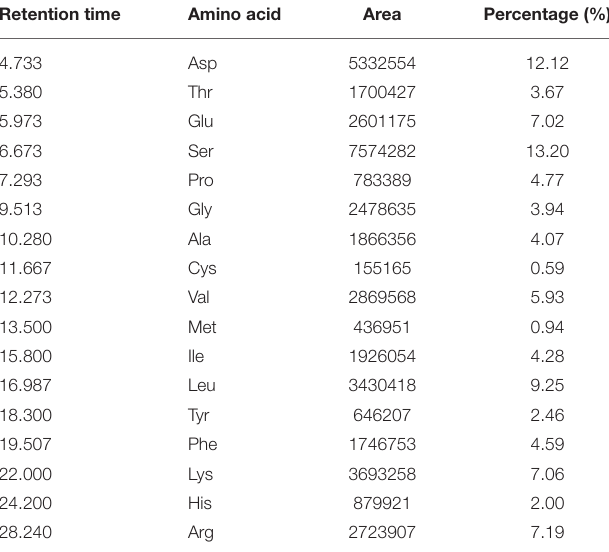
TABLE 1 | Amino acid composition of pea peptide (g / 100g